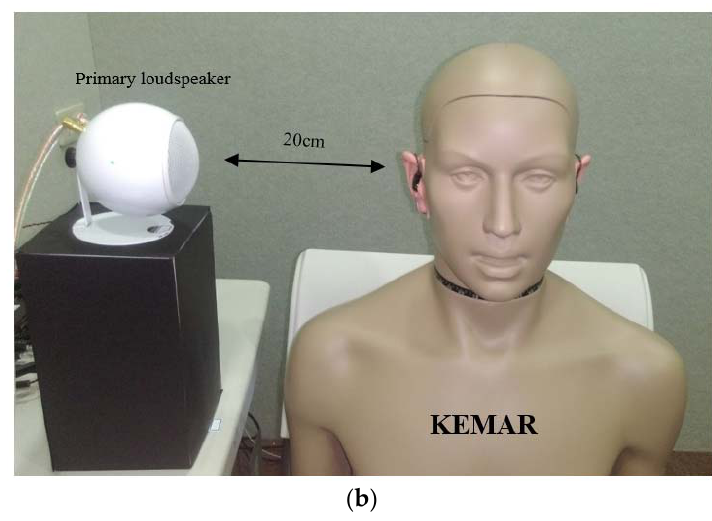
Figure 4. Experimental setup ( a ) for the clip earphone with attached error microphone ( b ) for testing ANC earphones and headphones.